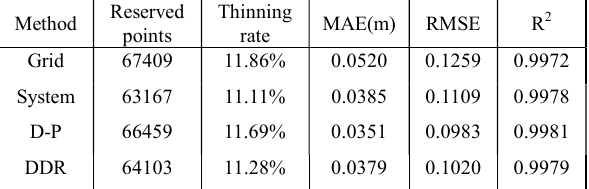
Table 2. Experimental results of the second group